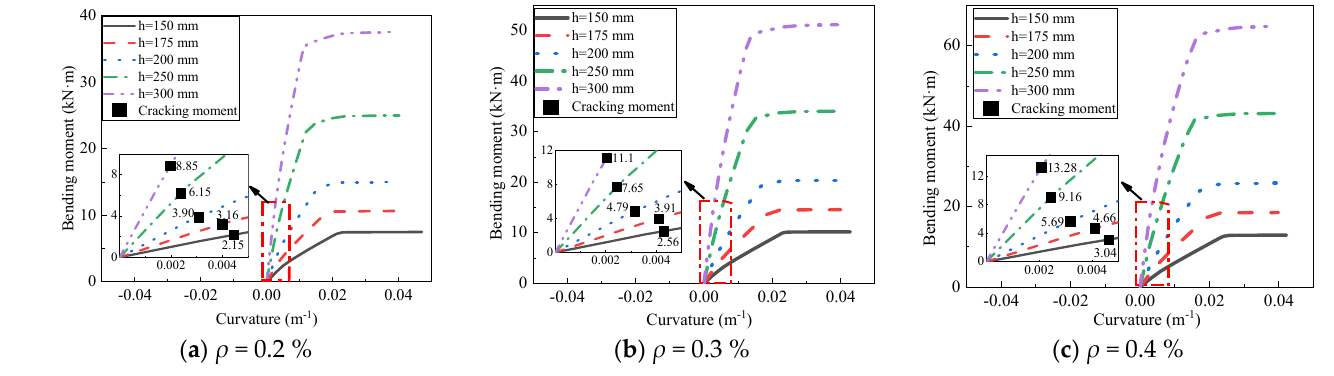
Figure 17. Effect of the thickness of the AAC